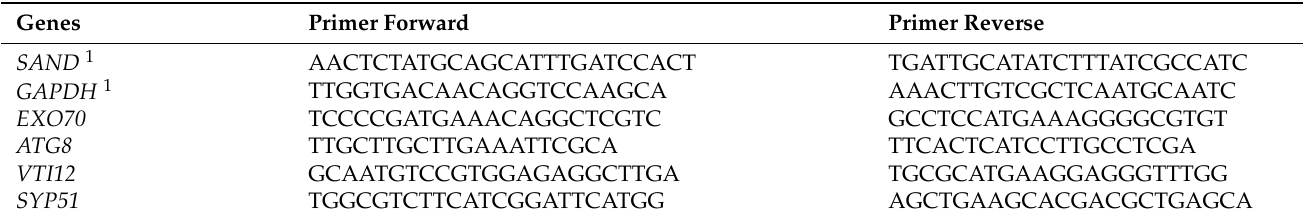
Table 2. List of genes and corresponding primer pairs used in the quantitative RT-PCR assay.